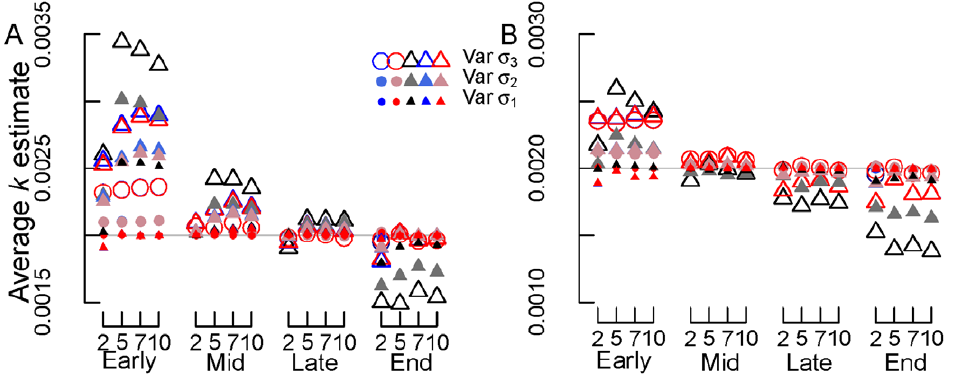
Figure 8. Average k estimates for simulations with variable normal errors (option 1). (A) SV and (B) REP transformations. Early, mid, late and end are early, mid, late and end stage decomposition simulations. The numbers 2, 5, 7 and 10 are the numbers of measurements used in each simulation. Blue circles=NLS, Red circles=Normal ML, gray/black circles=Beta ML. In most cases, nls=Normal ML so that the red circles cover the blue circles. Gray lines in panels (A) and (B) show the true k value of 0.002 d 2 1 .